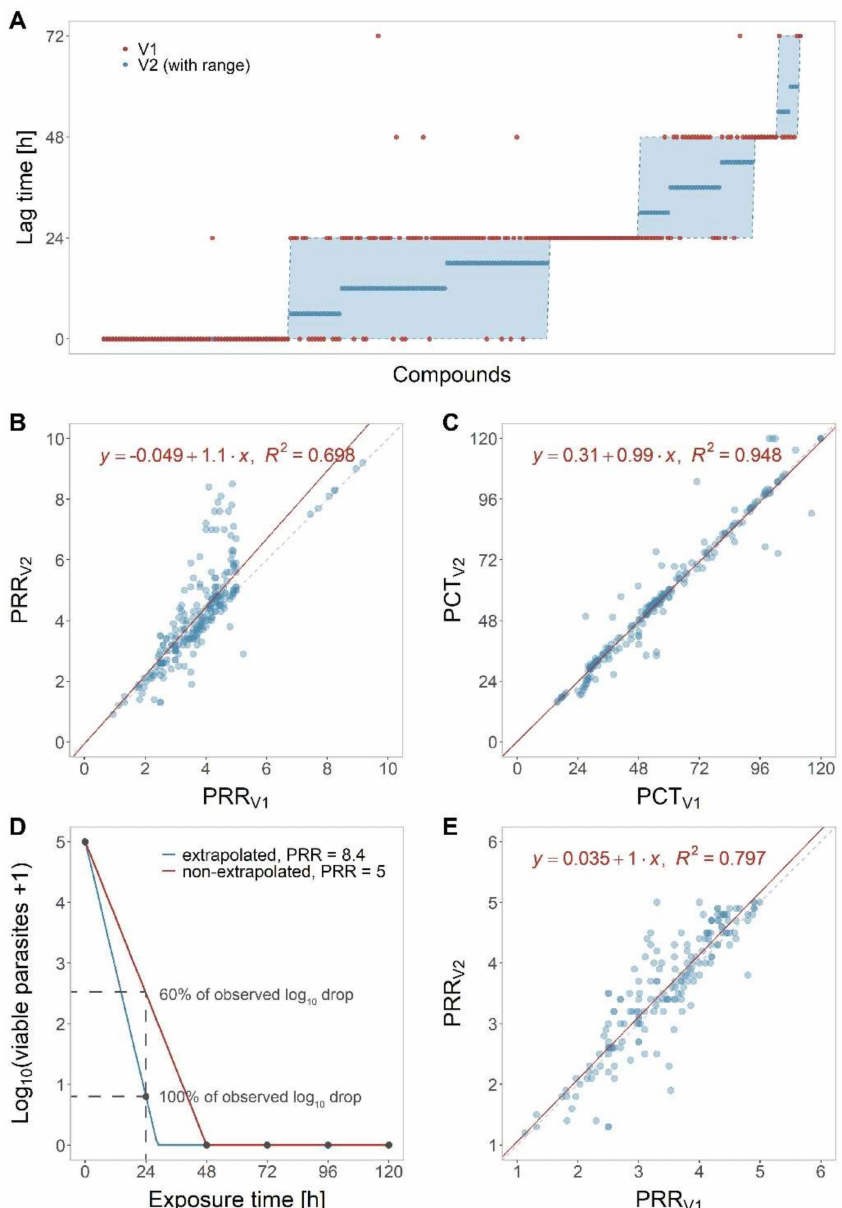
Figure 4. Validation of the new analysis method. PD parameter as obtained with PRR assay V1 or V2 analysis were compared for 232 molecules. ( A ) Comparison for lag time. ( B ) Comparison for PRR and ( C ) PCT 99.9% : the dashed, grey line indicates identity of the two methods, the red line is the linear regression with the equation and R 2 value displayed in the plot. ( D ) Demonstration of the effect on PRR values when extrapolating the slope between 0 and 24 h measurement to 48 h (blue) versus when not extrapolating (red). Not extrapolating results is underestimating the observed drop in parasites. ( E ) Linear regression for PRR when excluding all molecules with extrapolated PRR (PRR > 5) from the data set (n =